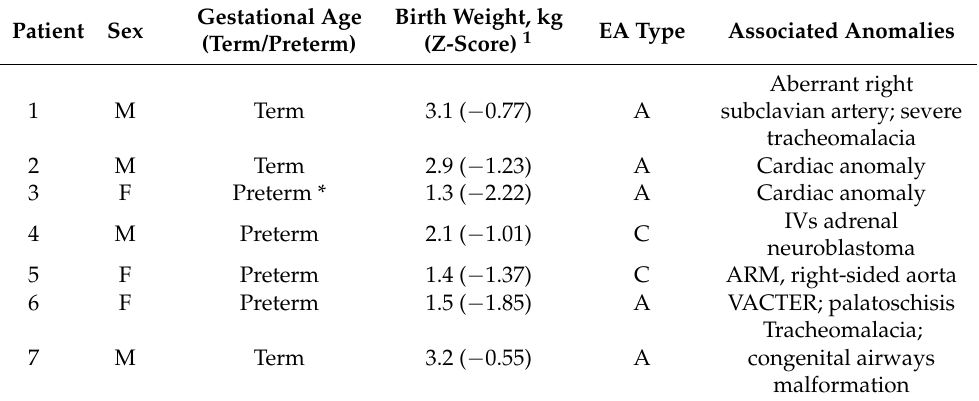
Table 1. Patients’ data and esophageal atresia (EA)